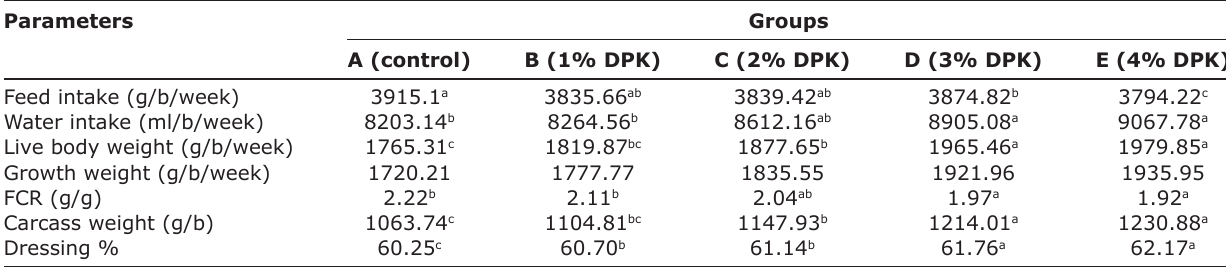
Table-3: The growth performance of broilers as influenced by feeding various levels of DPK for 6 weeks.